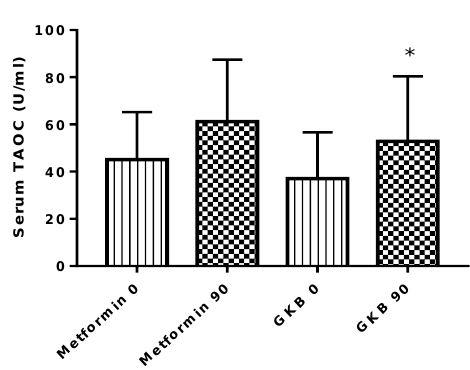
Figure 6. Effect of Gingko biloba extract (GKB) on the serum level of TAOC of patients with metabolic syndrome. Values were presented as mean ± S.D; * significantly different compared with baseline values (paired t -test, P <0.05).